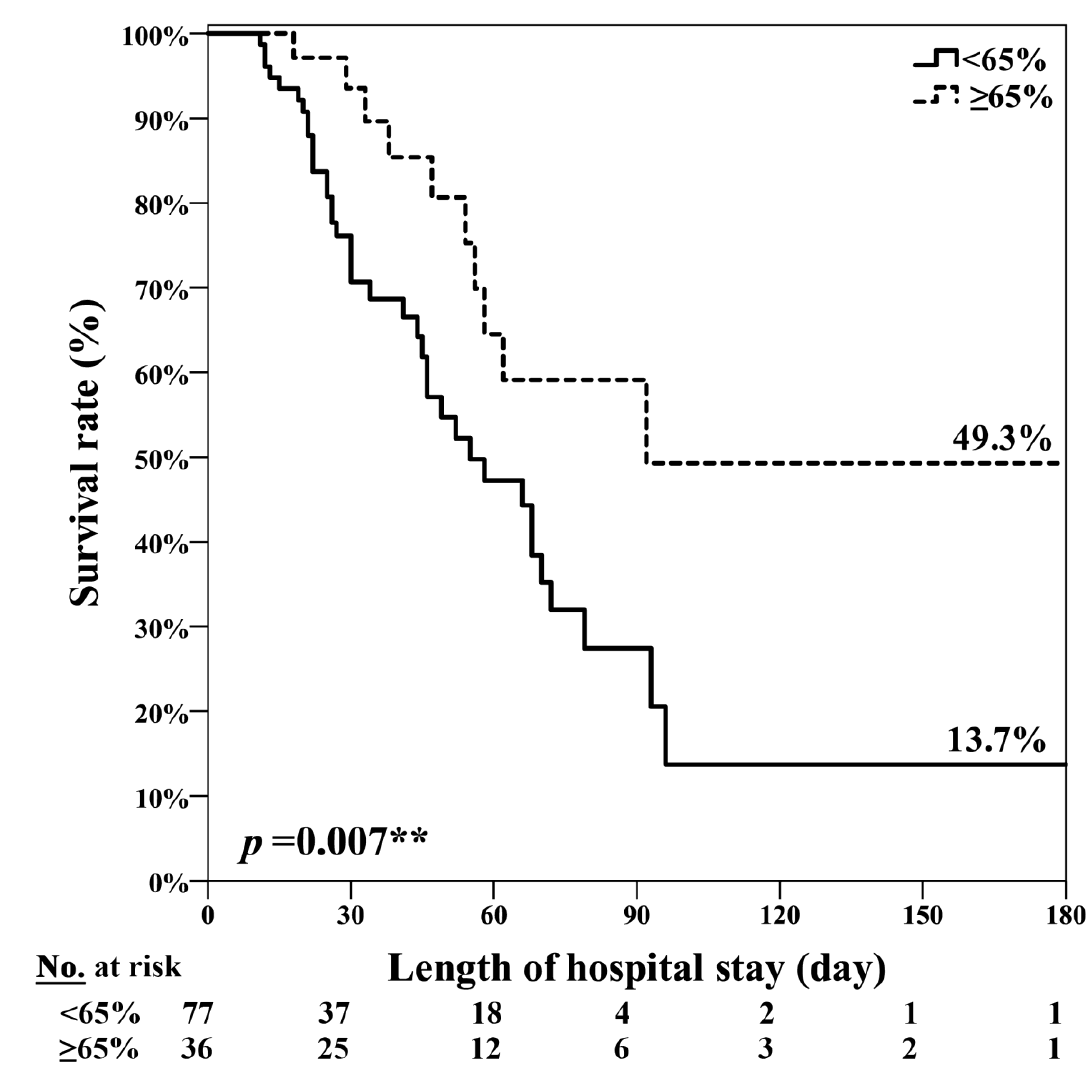
Figure 2. Energy achievement rate ≥ 65% on the 10th ICU day was significantly associated with lower hospital mortality in patients at high nutritional risk. ** p = 0.007.